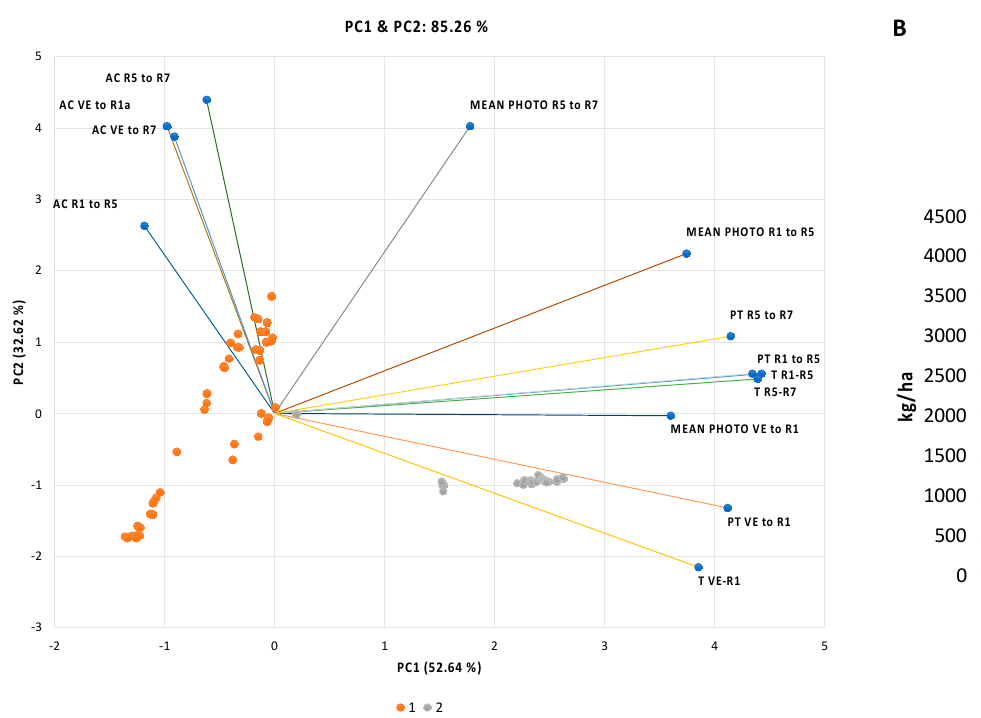
Figure 2. Variability of the climatic parameters and yield performance of the grain legume species between ENV1 and ENV2. ( A ) First (PC1) and second (PC2) principal component analysis (PCA) scores for the characterization of the climatic parameters of both environments. The direction of the vectors is shown by the lines (T = average daily temperature ( ◦ C); P = mean photoperiod (hours); AC = accumulated (hours); PT = photothermal units). Environmental groups are identified by color. ( B ) Multiple Tukey’s HSD at p < 0.05 comparison among the genotypes of the five grain legume species growing under two environments (ENV1 and ENV2) for seed yield (kg ha − 1 ). Significant differences among species, and significant interactions between species according to environment were recorded at p < 0.0001.